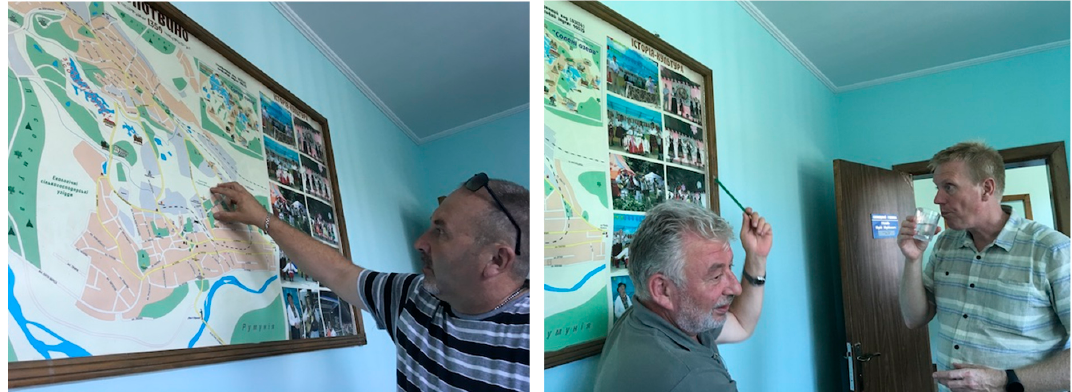
Figure 5. Images of the Solotvyno Deputy Mayor ( left image ) and Mayor ( right image ), explaining their perceptions of risk, while referring to the old Solotvyno paper map. Since there have been many environmental changes around the mines and there is a need to update the current paper map with a more recent paper map before undertaking further Solotvyno community risk perception